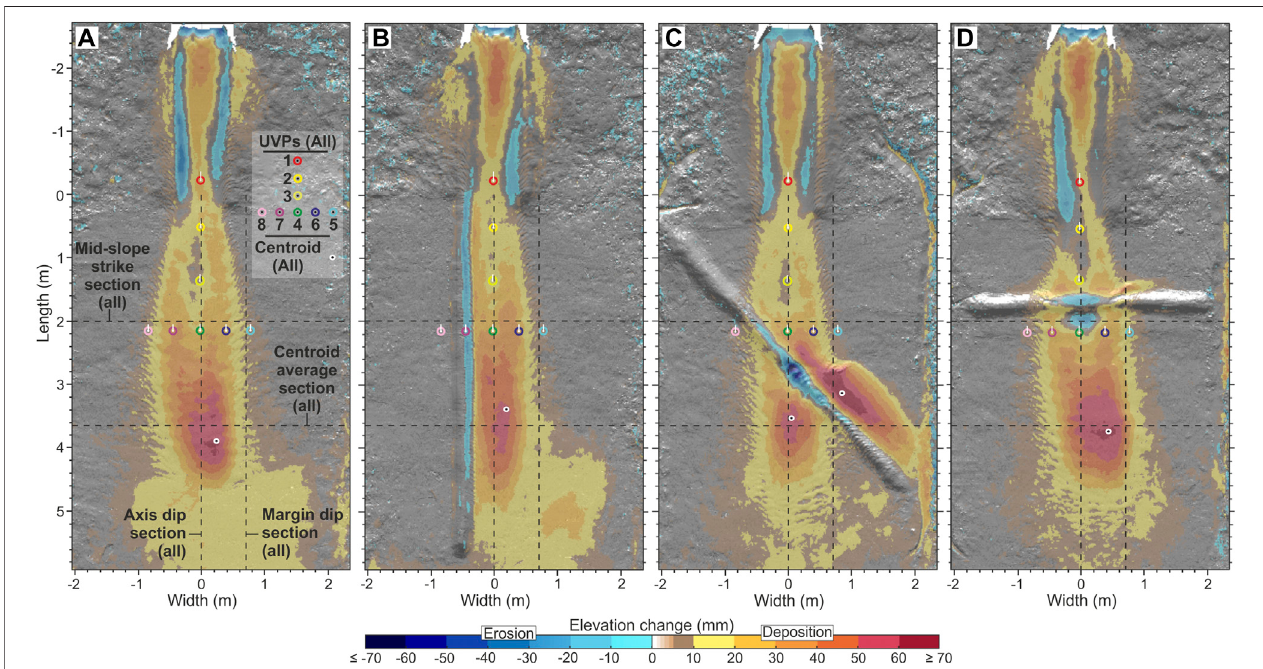
FIGURE 3 | Difference maps for the experimental runs discussed in this study. The maps are made by subtracting the laser scan derived elevation of the pre- experimenttanksurfacefromthepost-experimenttanksurface. (A) Uncon fi ned; (B) laterallycon fi ned; (C) obliquelycon fi ned,and (D) frontallycon fi ned.Erosionisshown in blue and deposition is shown in yellow, orange and red. White tick on the UVP represents the approximate limit of upstream velocities captured by that